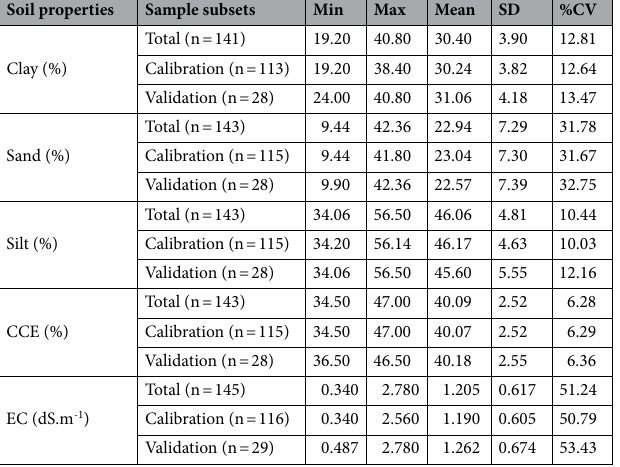
Table 2. Summary of descriptive statistics values for the total, calibration, and validation reference data subsets of the selected soil physicochemical properties. CCE calcium carbonate equivalent, CV coefficient of variation, EC electrical conductivity, Max . maximum, Min. minimum, SD standard deviation.